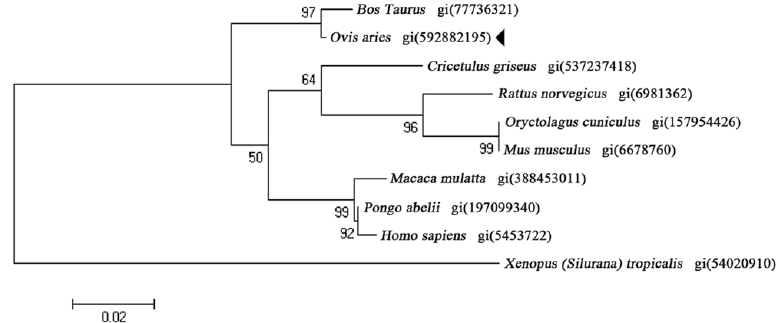
Figure 3. Phylogenetic relationship of LYPLA1 proteins from different species. The phylogenetic tree was constructed using MEGA 4.1 with the ClustalW algorithm. The number on the nodes indicates bootstrap values from 1000 replications.